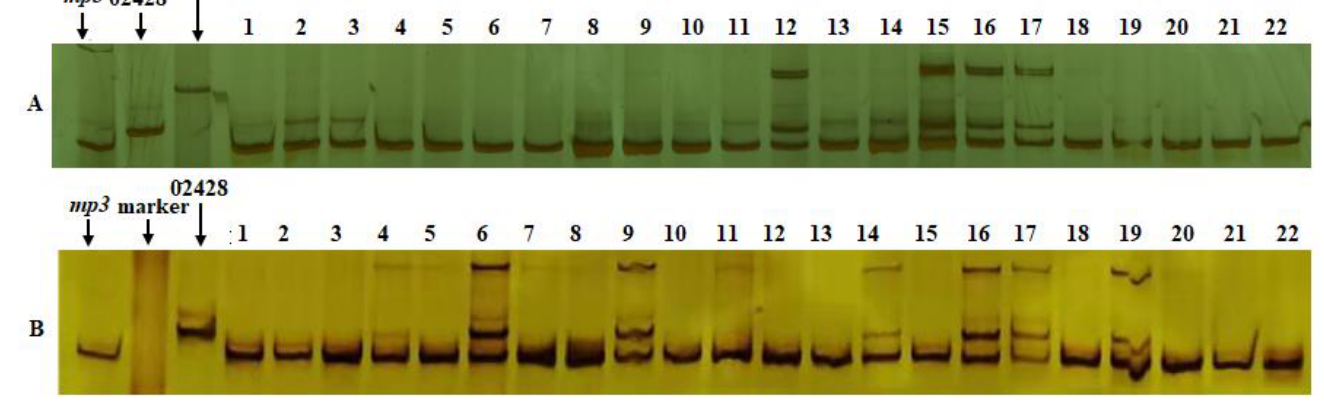
Figure 5. Segregation of the SSR RM3467 and RM7197 markers in the F 2 population derived from the cross of 02428 and mp3. Marker. DL-2000 plus DNA marker; ( A ) Male parent mp3; female parent 02428. Marker.1-22: PCR amplification of RM3467 with 22 multi-pistil individual plants (homozygote or heterozygote) in the F 2 population. ( B ) Male parent mp3; female parent 02428. Marker.1-22: PCR amplification of RM7197 with 22 multi-pistil individual plants (homozygote